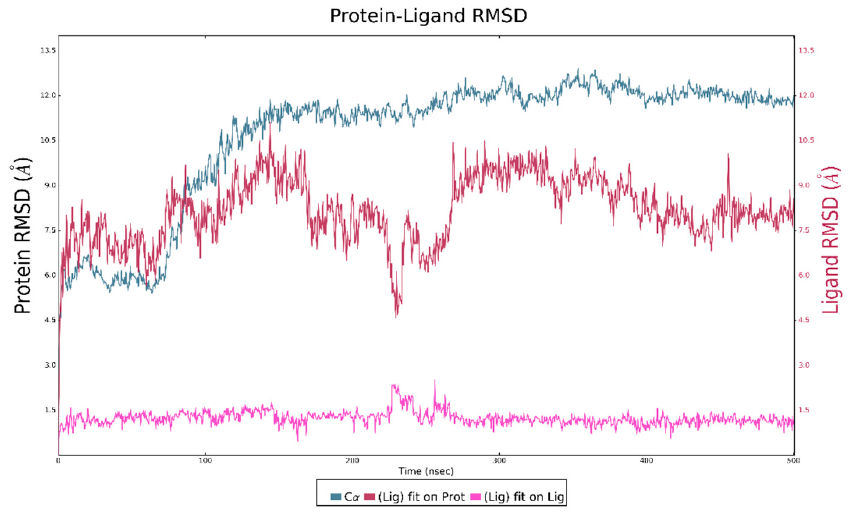
Figure 7. Molecular dynamics Root Mean Square Deviation (RMSD) plot.